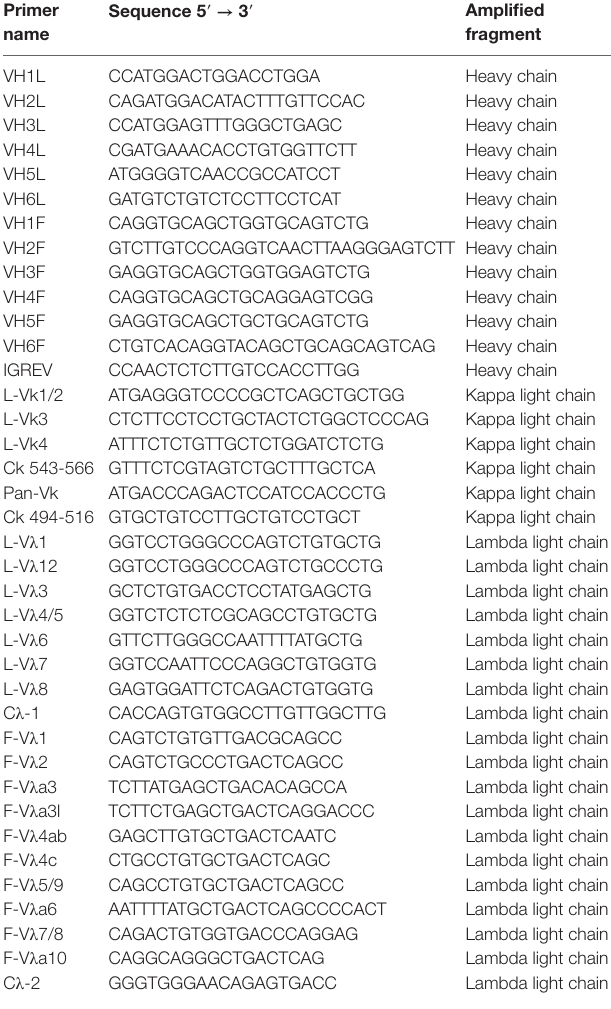
TaBle 1 | Nested PCR immunoglobulin